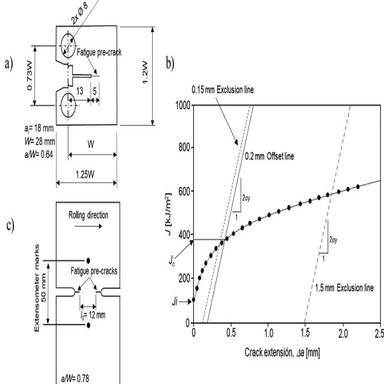
(a) CT specimen geometry used for J-integral measurements. (b) Construction of the J-R curve according to ASTM E1820 and determination of the fracture toughness parameters Ji and Jc. (c) DENT specimen for J-integral measurements.